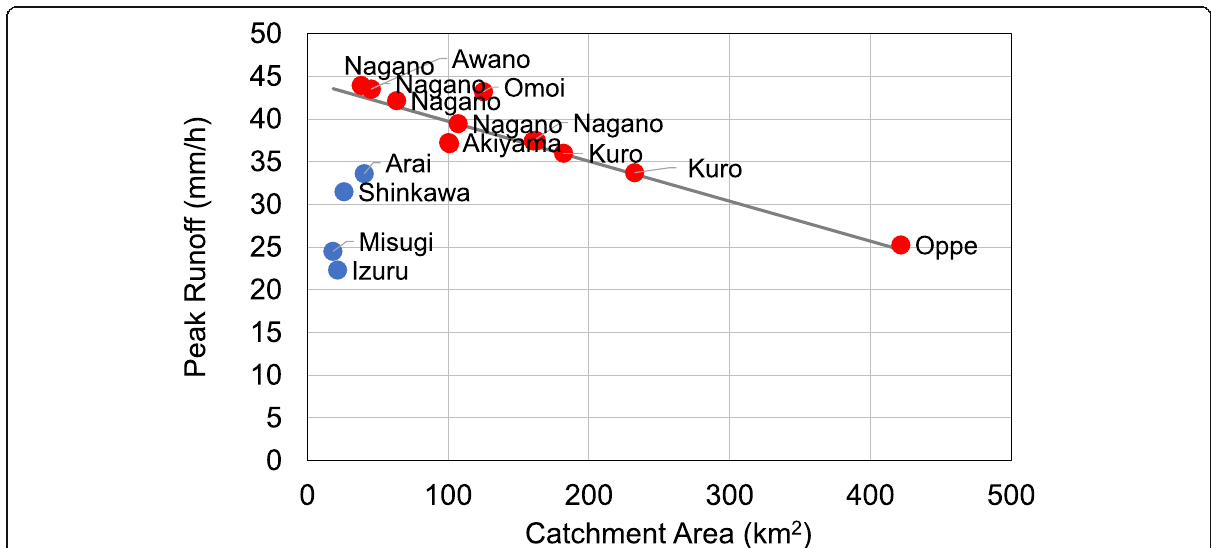
Fig. 10 Simulated peak runoff at levee breaching points in small to medium sized rivers in Tochigi Prefecture (and Saitama Prefecture for the Oppe River). The red points are rivers that originated from mountains, while the blue points are rivers that originated from plains (< 400 m in this region), whose bank-full discharges are typically